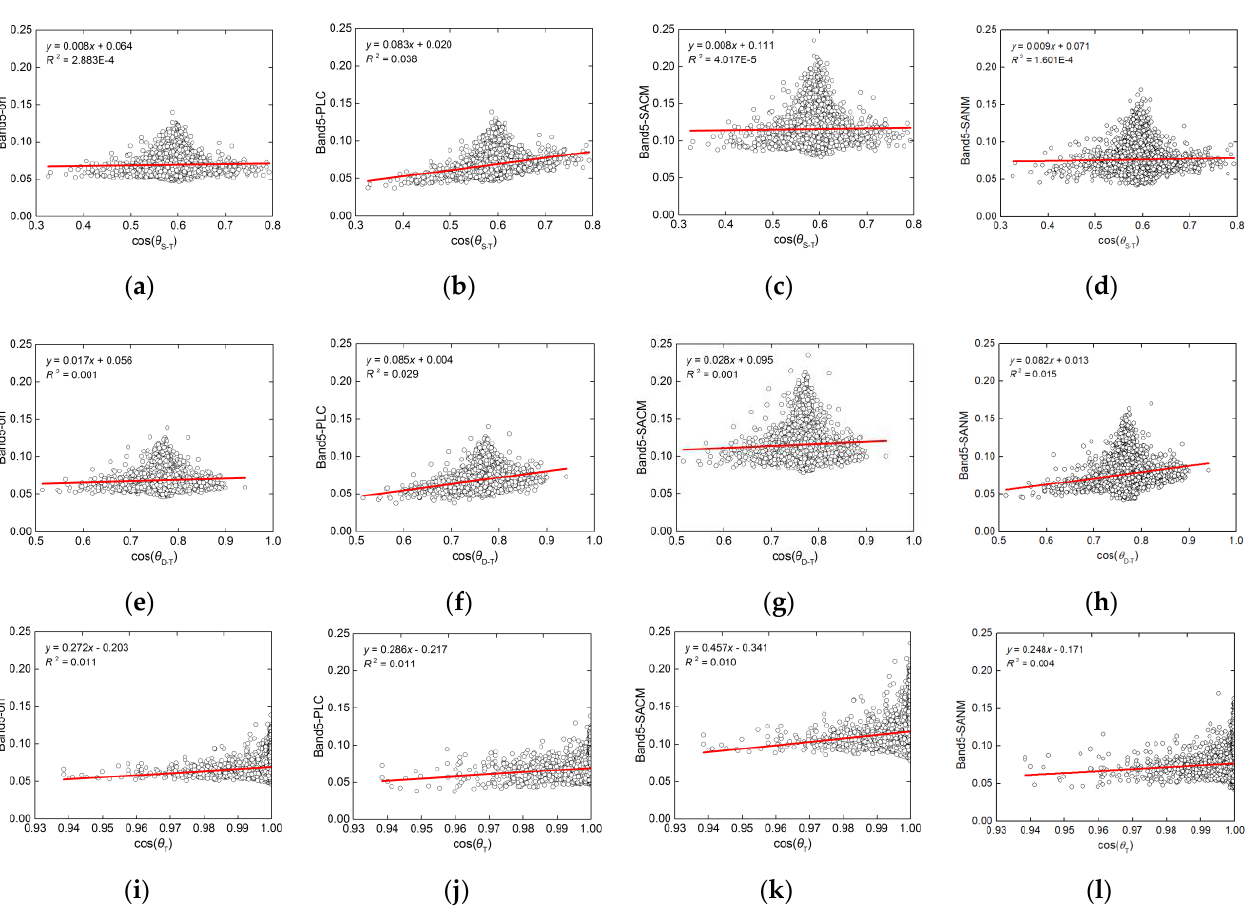
Figure 5. ( a ) Density scatter plots between the original Rayleigh-corrected GOCI band 5 reflectance (Band5-ori) at 08:15 CST and 𝑐𝑜𝑠(𝜃 S−T ) , the red line is linearly fit to data; ( b ) Same as ( a ) except using the GOCI band 5 reflectance after PLC correction (Band5-PLC); ( c ) Same as ( a ) except between the GOCI band 5 reflectance after ASCM correction with Band5-ori as 𝜌 t (Band5-SACM); ( d ) Same as ( a ) except between the GOCI band 5 reflectance after SANM normalization (Band5-SANM); ( e ) Same as ( a ) except using the 𝑐𝑜𝑠(𝜃 D−T ) ; ( f – h ) Same as ( e ) except using Band5-PLC, Band5-SACM, and Band5-SANM, respectively; ( i ) Same as ( a ) except using the 𝑐𝑜𝑠(𝜃 T ) ; ( j – l ) Same as ( i ) except using Band5-PLC, Band5-SACM, and Band5-SANM, respectively.